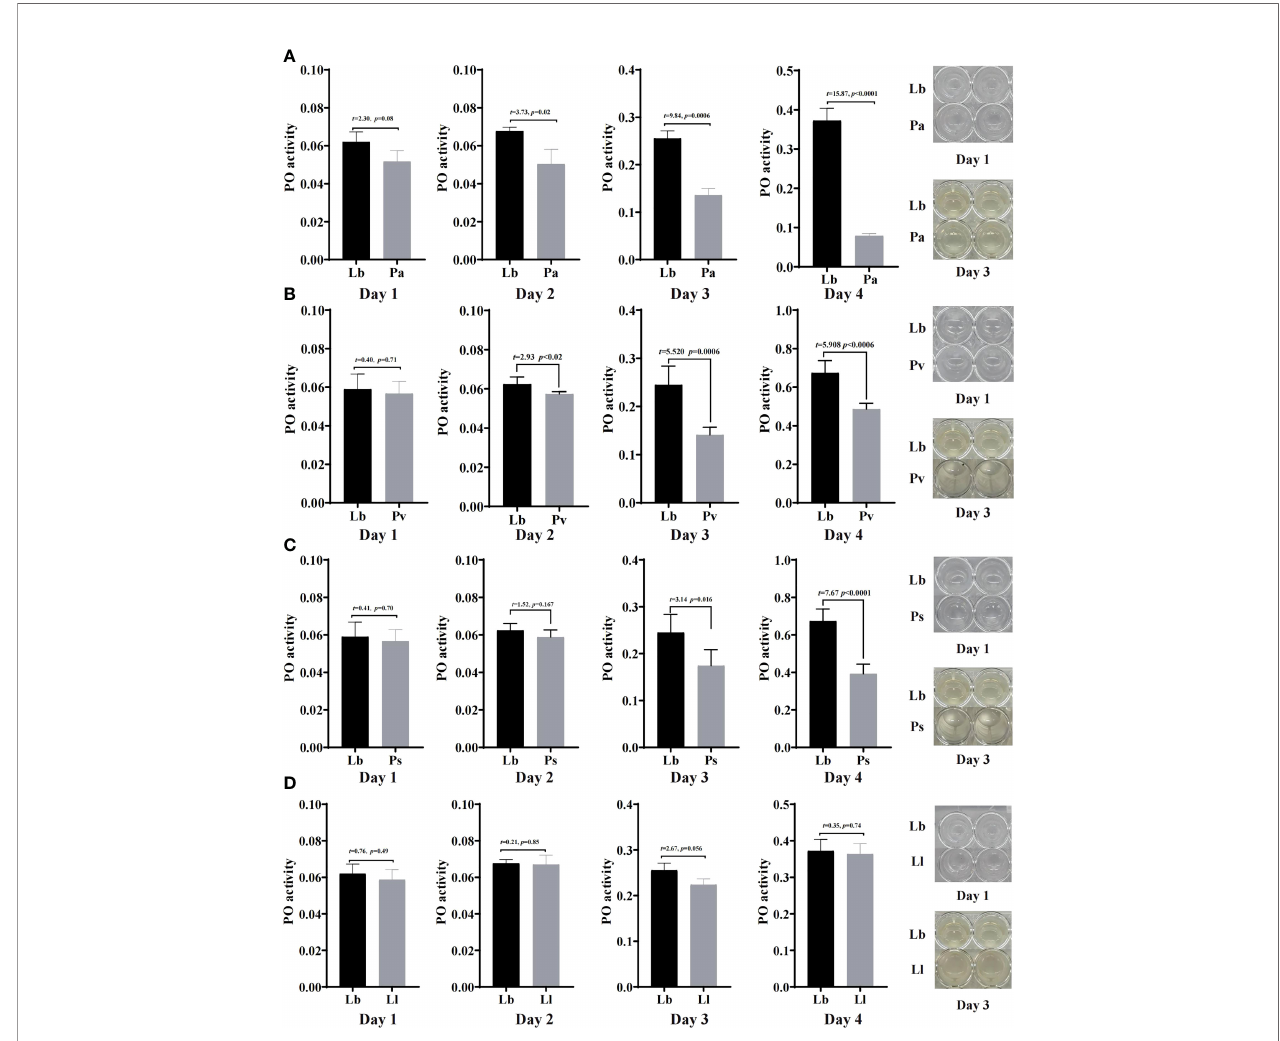
FIGURE 7 | Effects of “ harmful bacteria ” (A – C) and “ neutral bacteria ” (D) in the guts of house fl y larvae on phenoloxidase activity in the hemolymph. Ya, Pseudomonas aeruginosa ; Ps, Providencia stuartii ; Pv:, Providencia vermicola ; Ll, Lactococcus lactis . Day 1, Day 2, Day 3, Day 4: the developmental period of house fl y